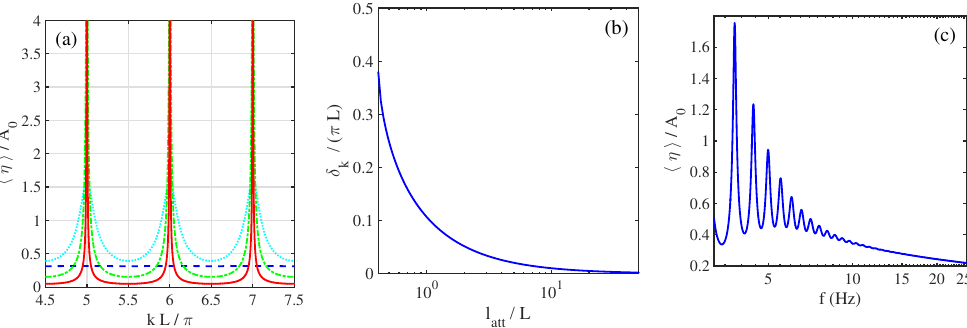
Figure 8. ( a ) (cid:104) η (cid:105) / A 0 as a function of kL / π for different levels of wave dissipation, quantified by the attenuation length l att = 0.2 L (blue dashed line), l att = 2 L (cyan dotted line), l att = 20 L (green dashed-dotted line), and l att = 200 L (red plain line). Here, l att is varied independently of k to simplify the discussion. For a small-enough dissipation wavenumber quantization for k , a multiple of π / L is found. ( b ) Half width at half maximum of the resonant peak as a function of l att . ( c ) (cid:104) η (cid:105) / A 0 as function of the wave frequency using the following parameters: container size L = 165 mm, the gravity–capillary wave dispersion relation, and increasing dissipation rate with frequency, according to the inextensible film model δ inex . Wave-mode quantization disappears above f > 10